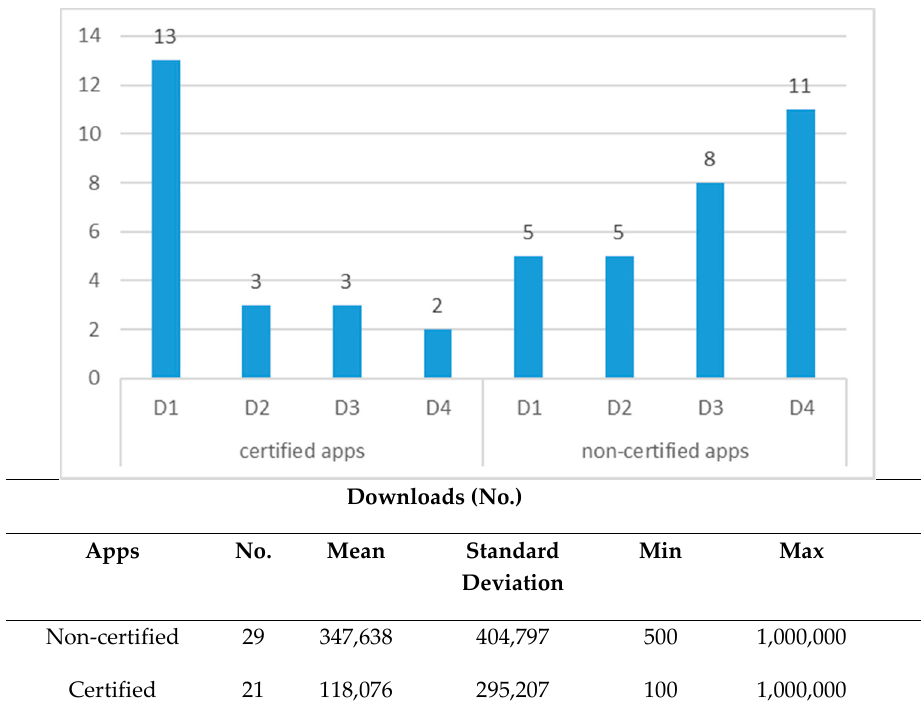
Figure 3. Distribution of apps according to download behaviour ( n = 50 apps).